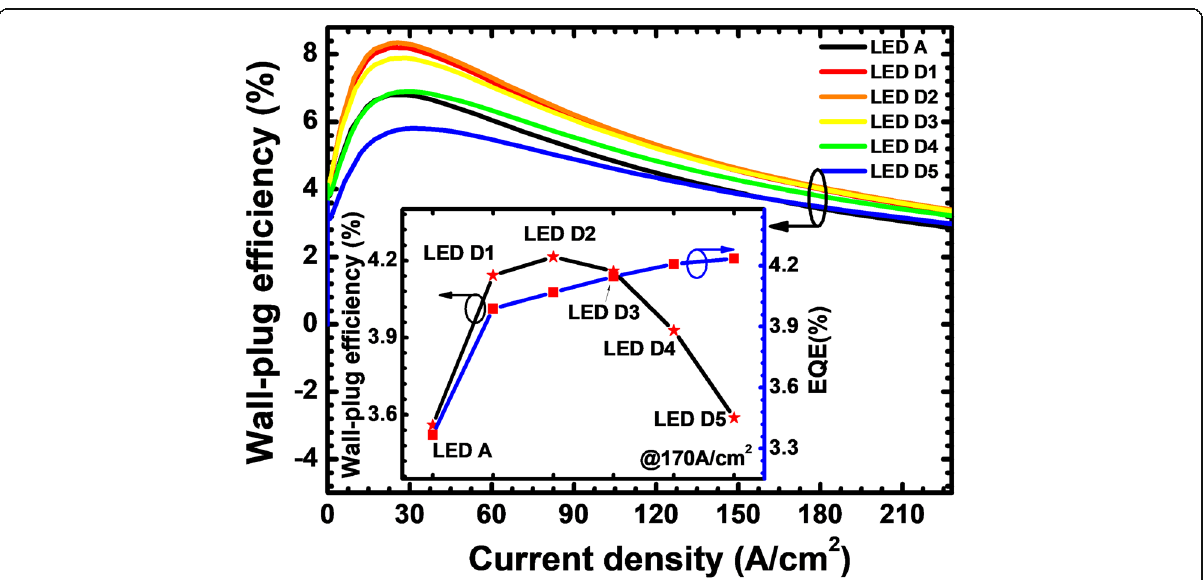
Fig. 11 WPE as a function of the injection current for LEDs A, D1, D2, D3, D4, and D5. Inset figure shows the WPE and EQE for the studied LEDs with various doping concentrations of the n-Al